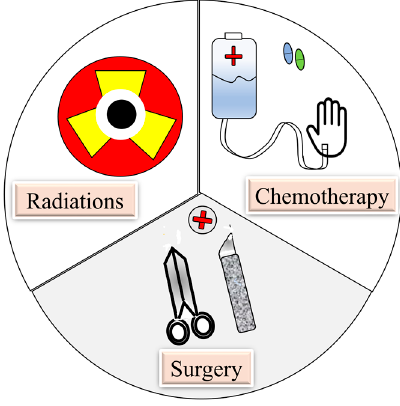
Figure 1. Traditional therapies for GBM.